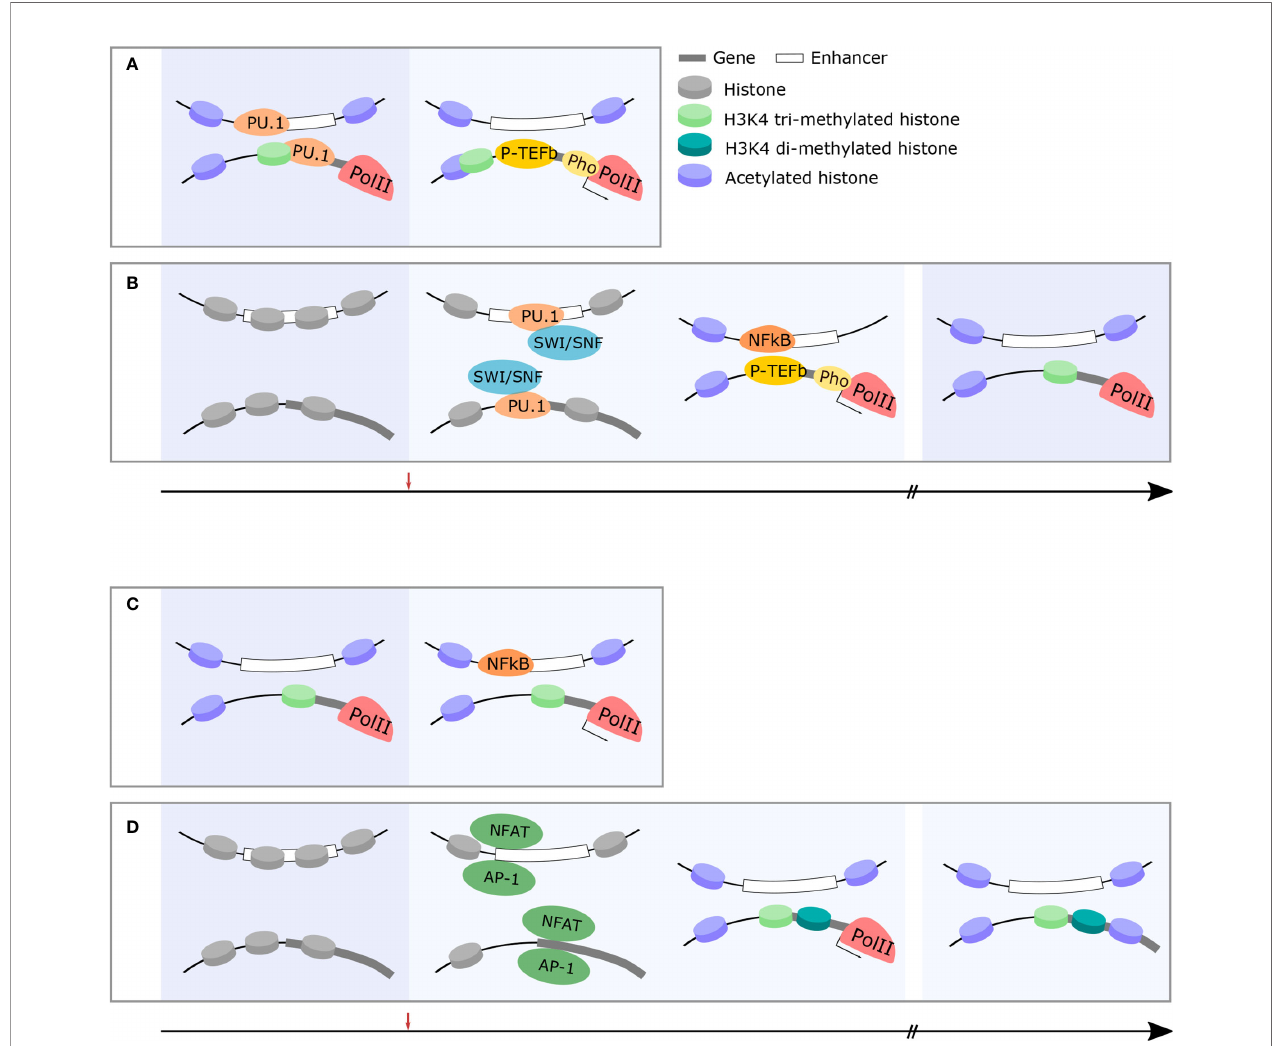
FIGURE 2 | Immune cells exhibit changes in chromatin structure which facilitate rapid, robust responses and facilitate long-term memory. (A) Rapid-response genes in innate immune cells are primed for rapid and robust responses in the naïve state. Permissive chromatin marks, acetylation and H3K4 trimethylation, at gene promoters, facilitate the pre-loading and stabilization of RNAPII at rapid-response gene promoters (left panel). Following challenge, P-TEFb phosphorylates RNAPII and active transcription takes place within minutes (right panel). (B) Early-response immune genes are primed following immune challenge and maintain epigenetic memory to facilitate rapid and robust responses in future. In the naïve state, early-response immune gene loci are inaccessible chromatin structure (left panel). Following immune challenge, pioneer TFs (PU.1) recruit the SWI/SNF complex (middle-left panel) which, in turn, histone-modifying enzymes and facilitates the recruitment of permissive histone marks and immune-speci fi c TFs (NFkB) initiate the transcription cascade (middle-right panel). This occurs within 30 min and the epigenetic modi fi cation of these loci is maintained to facilitate rapid and robust responses in future (right panel). (C) Rapid-response genes in T cells are primed for rapid and robust responses in the naïve state. Similarly to innate immune cells, permissive chromatin marks, acetylation and H3K4 trimethylation, at gene promoters, facilitate the pre-loading and stabilization of RNAPII at rapid-response gene promoters (left panel). This allows for rapid transcription of these genes within minutes following immune challenge even in adaptive cohorts of cells (right panel). (D) T cell effector genes are epigenetically modi fi ed over time following immune challenge to facilitate long-term immune memory and more effective responses following future challenge. In the naïve state, effector gene loci are silenced by